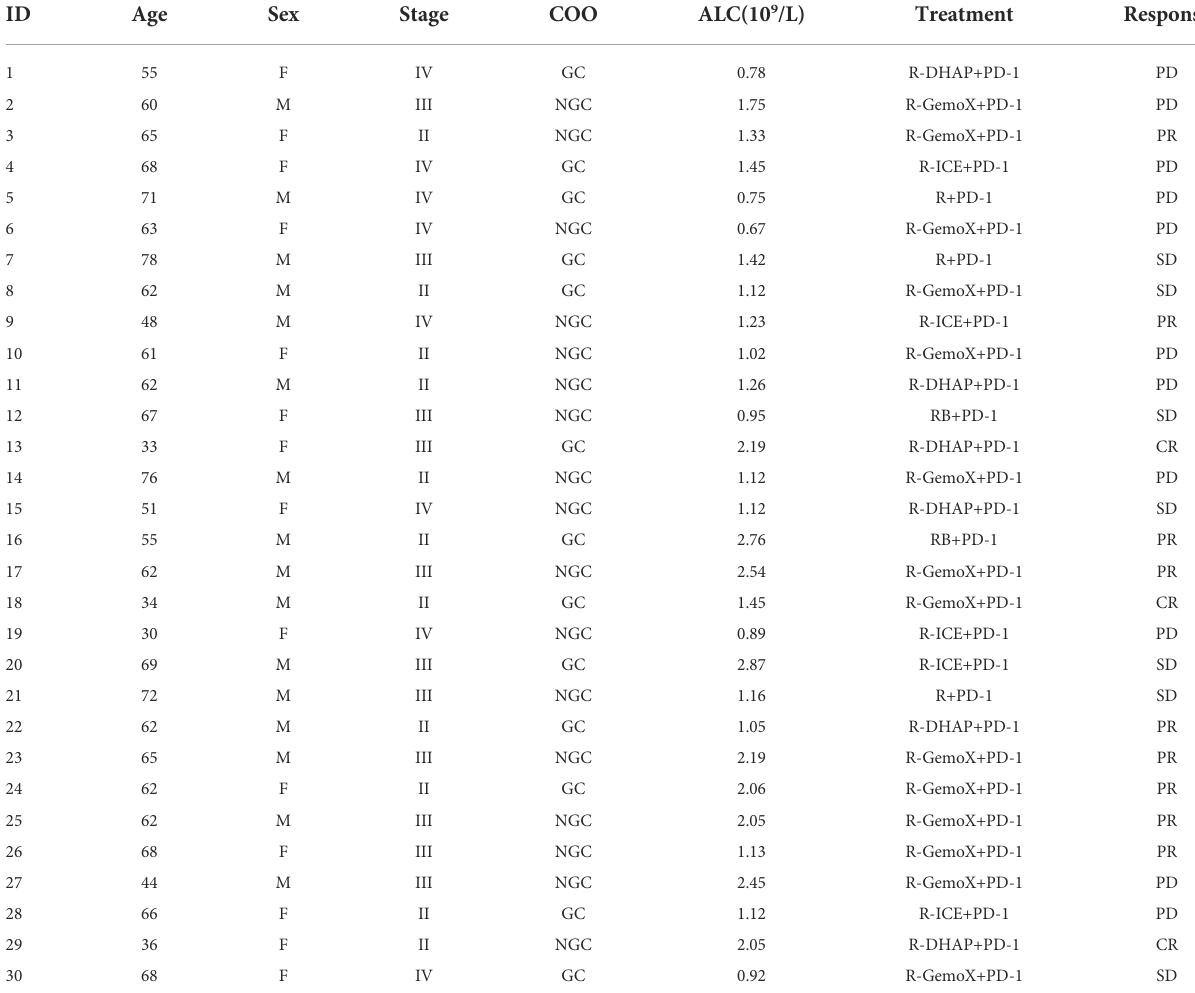
TABLE 1 Clinical characteristics of 30 r/rDLBCL patients with second-line treatments with PD-1